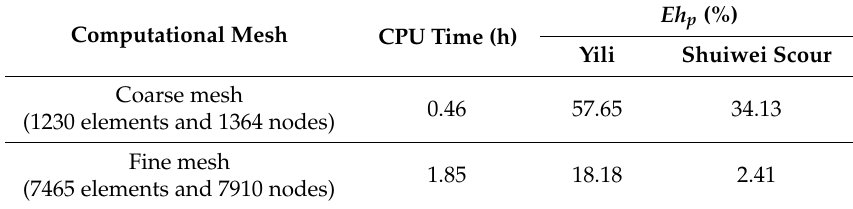
Table 4. Simulated results using two di ff erent computational meshes for Typhoon Nesat.